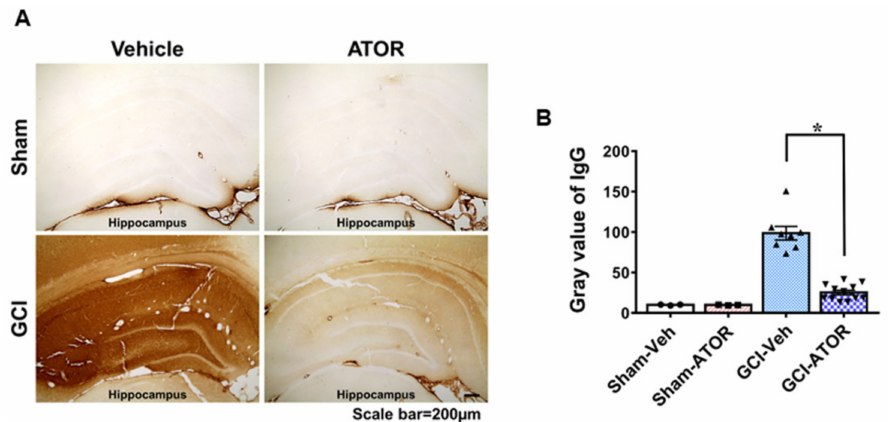
Figure 4. Atorvastatin prevents blood–brain barrier disruption after global cerebral ischemia. Due to ischemic damage, BBB was disrupted, as seen from the high concentration of serum IgG that leaked out through damaged vessels. In the sham-operated group, no IgG leakage was observed because the BBB remained intact; in the ischemia-induced group, the BBB was destroyed, and IgG consequently leaked from the damaged vessels, which was confirmed by a chemical reaction ( A ). The degree of IgG extravasation decreased in the GCI-ATOR group, indicating the protective effects of atorvastatin towards the BBB. Scatter dot plot bar graph representing the degree of IgG leakage in the whole hippocampus ( B ). Data are mean ± S.E.M., n = 3 for each sham group, n = 8~12 for each ischemia group. * Significantly different from the vehicle-treated group, * p < 0.05.